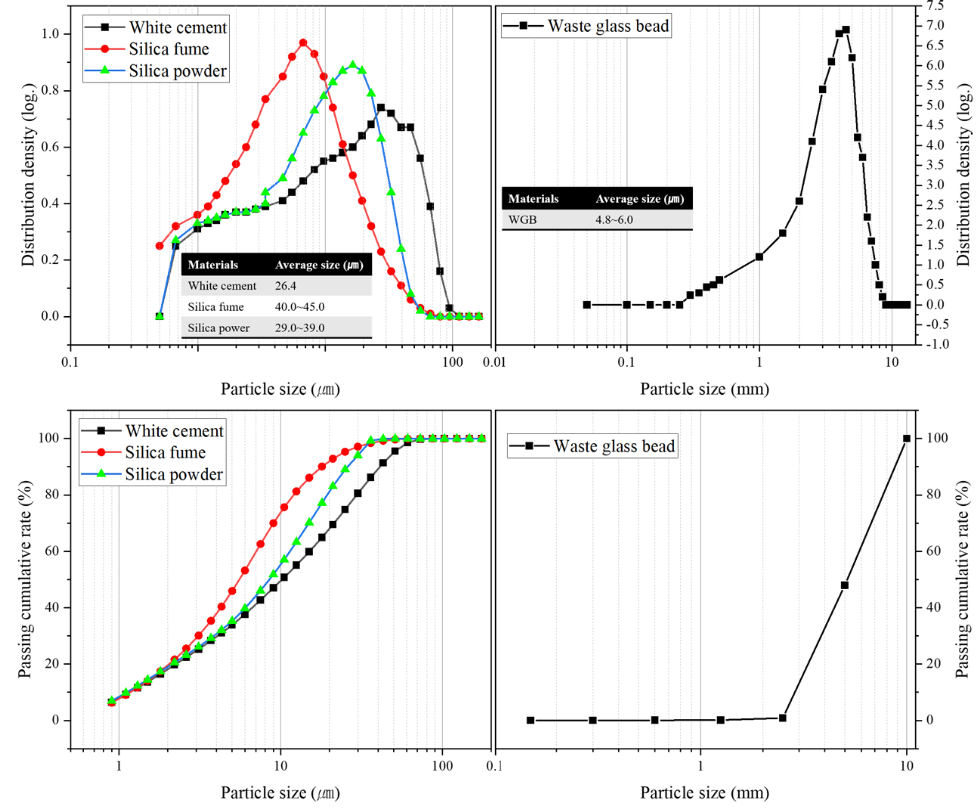
Figure 2. Particle size distribution and cumulative passing rate of binders and WGBs.